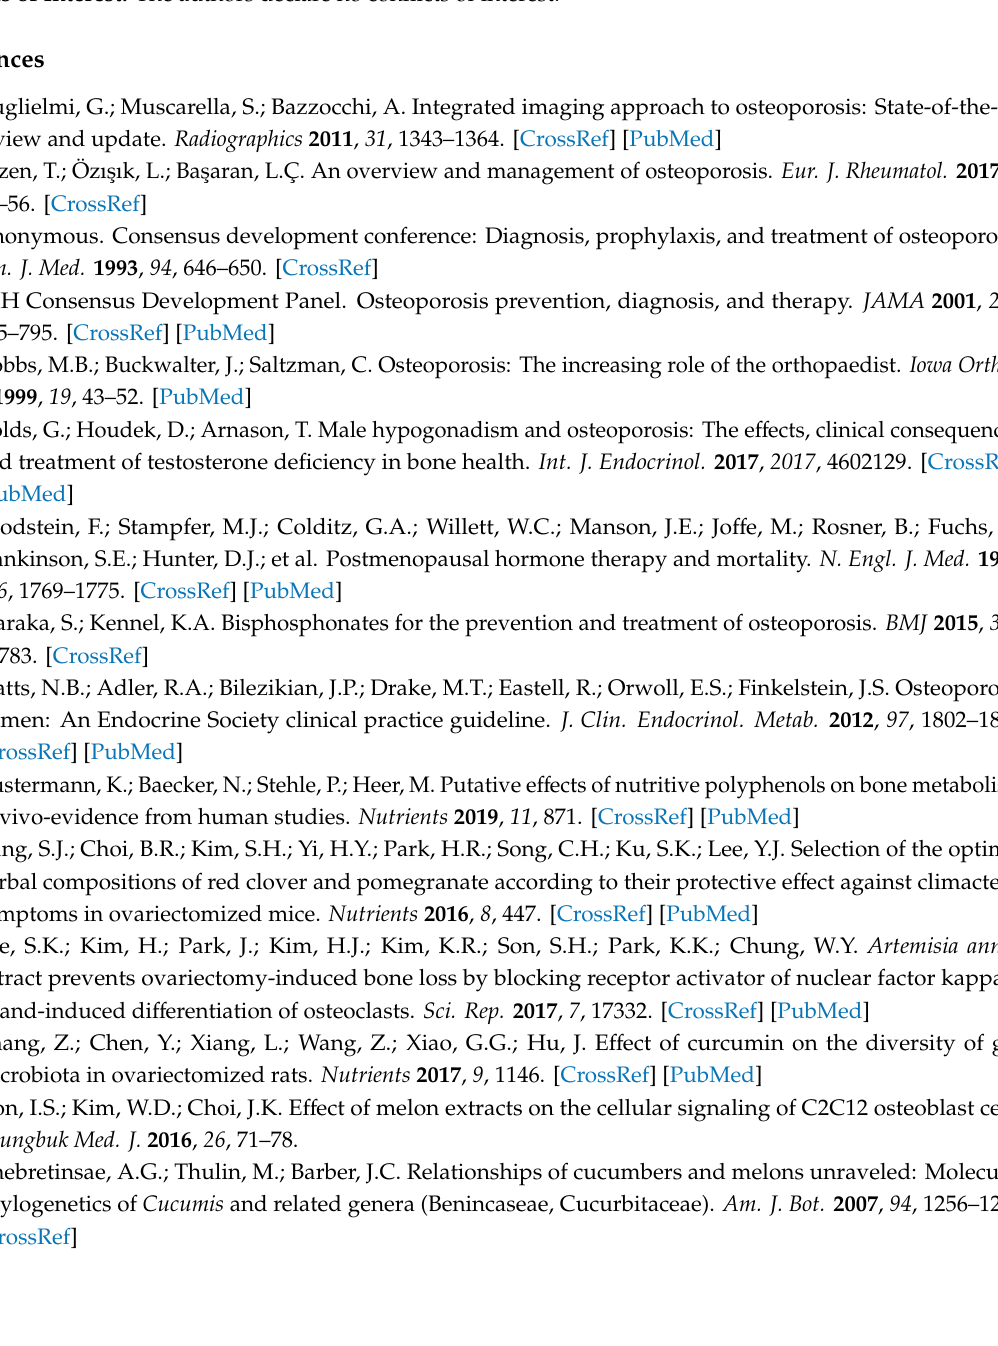
Figure S1: Antioxidant activity of melon extracts treated without or with heat (ECO-A) determined by measuring DPPH radical scavenging activity, Table S1: Ingredient of diets used in this